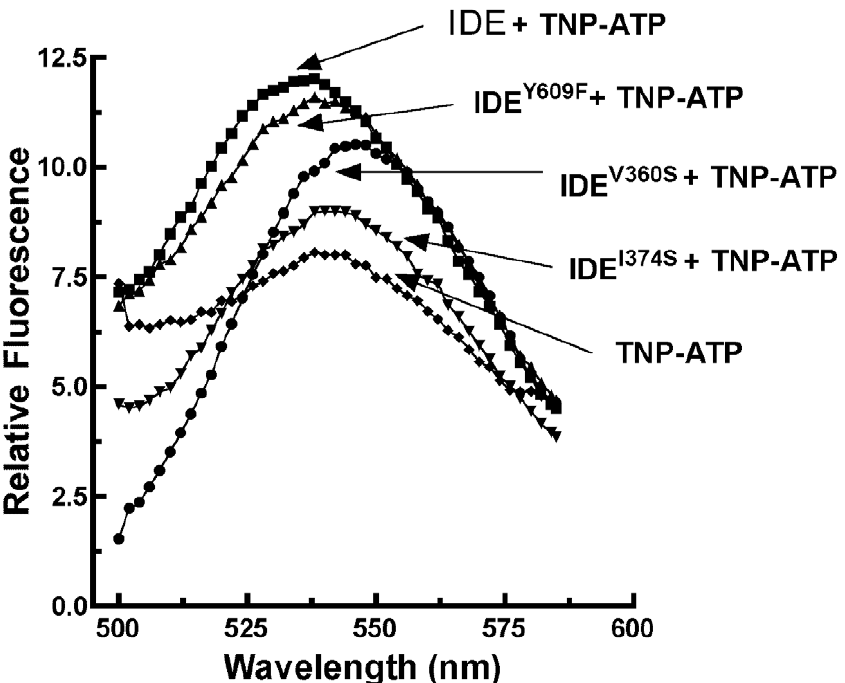
Figure 4. Fluorescence spectra of TNP-ATP bound to wild type IDE and the distal mutants. Fluorescence emission spectra of 10 m M TNP- ATP in 50 m M Tris-HCl, pH 7.4, was measured in the presence of 1.5 m M of each wild type IDE and the indicated IDE distal mutants. Fluorescence spectra were recorded with a l exc =403 nm on a Perkin-Elmer LS55 Luminescence Spectrometer.